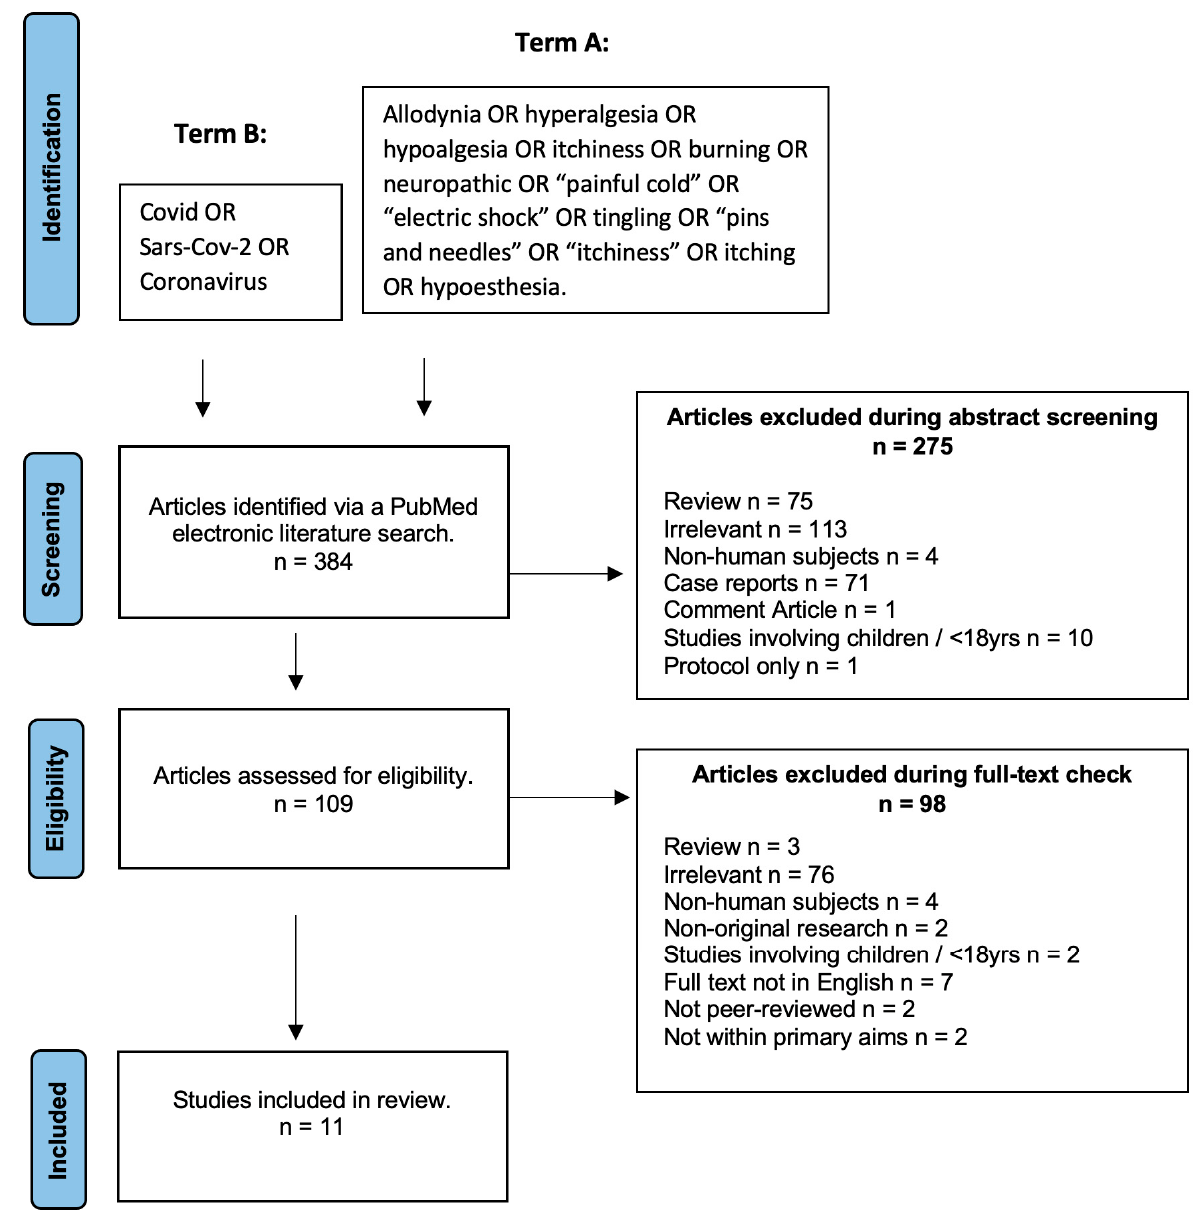
Figure 1. PRISMA chart displaying the screening and inclusion process for the COVID-19-related neuropathic pain systematic review and meta-analysis.